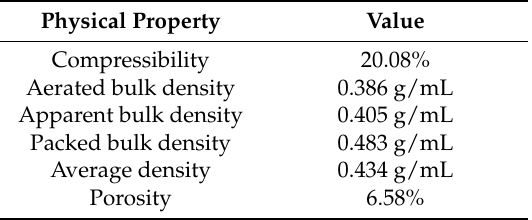
Table 1. Bulk properties of ground vulcanized rubber, Tyler mesh 14–16 from waste tyres.